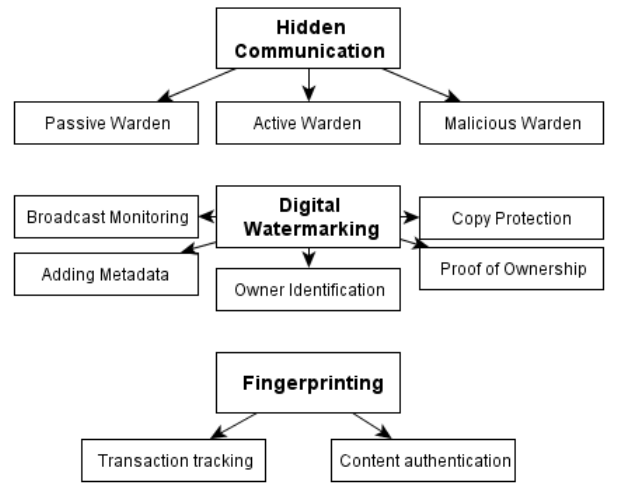
Fig. 3. The main application fields of digital steganography.